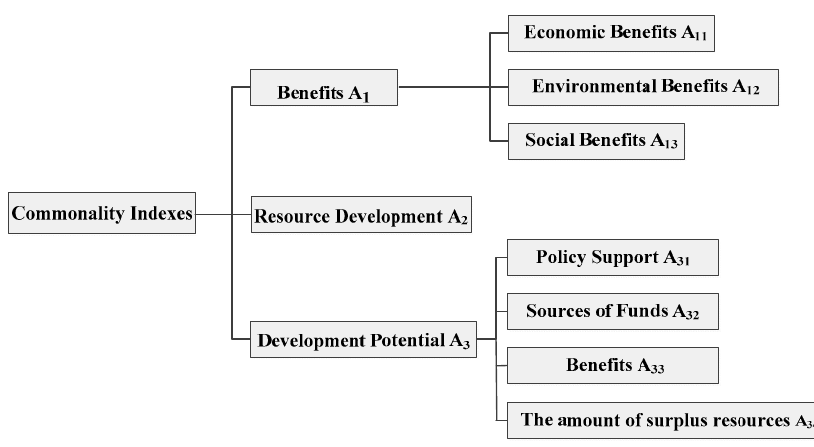
Figure 2. The framework of the commonality indexes.